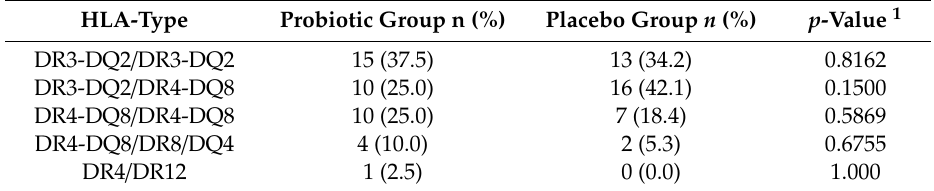
Table 2. Human leucocyte antigen (HLA) distribution among the 78 children that completed the